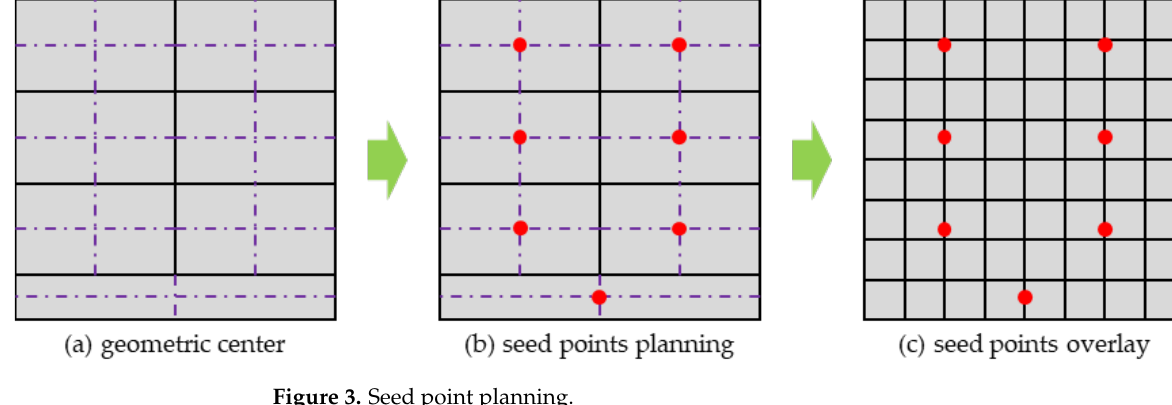
Figure 3. Seed point planning.